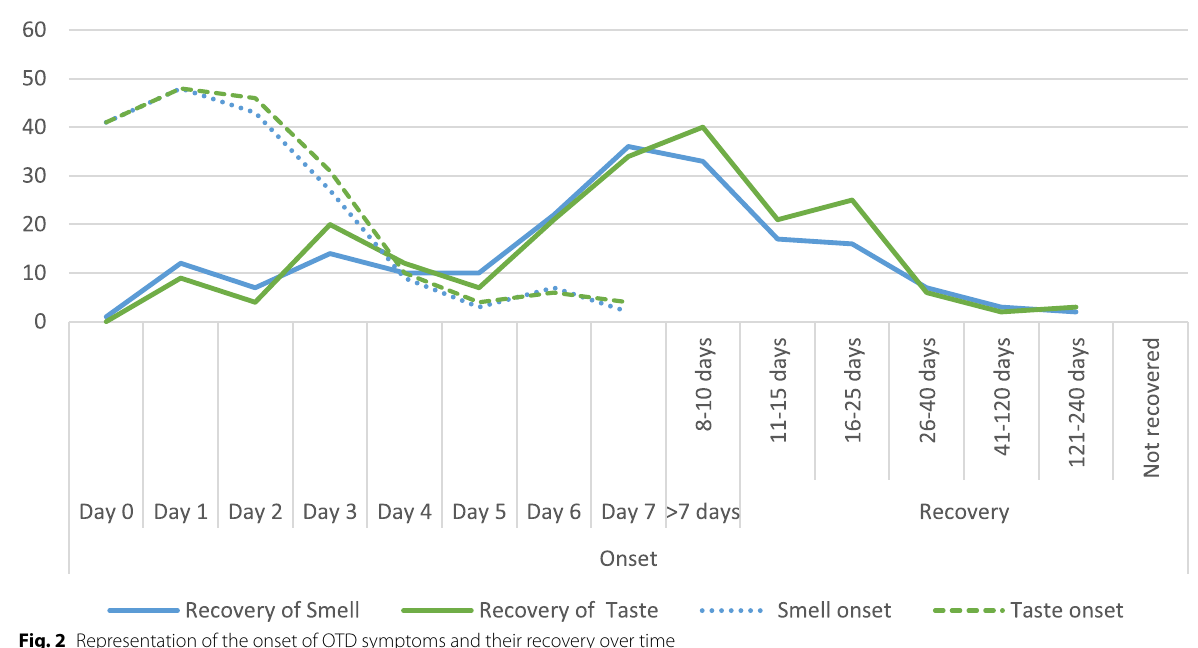
Fig. 2 Representation of the onset of OTD symptoms and their recovery over time